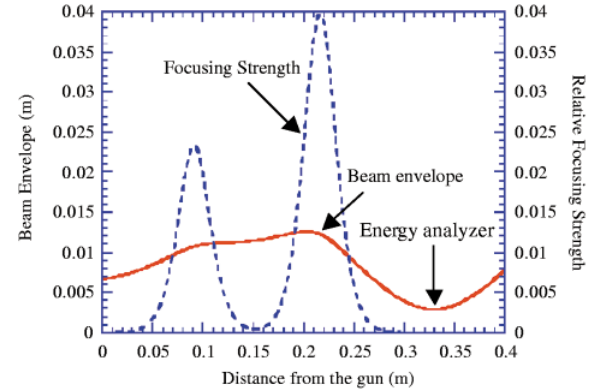
FIG. 7. (Color) Typical beam envelope in the transport line. FIG. 8. (Color) Typical energy analyzer output